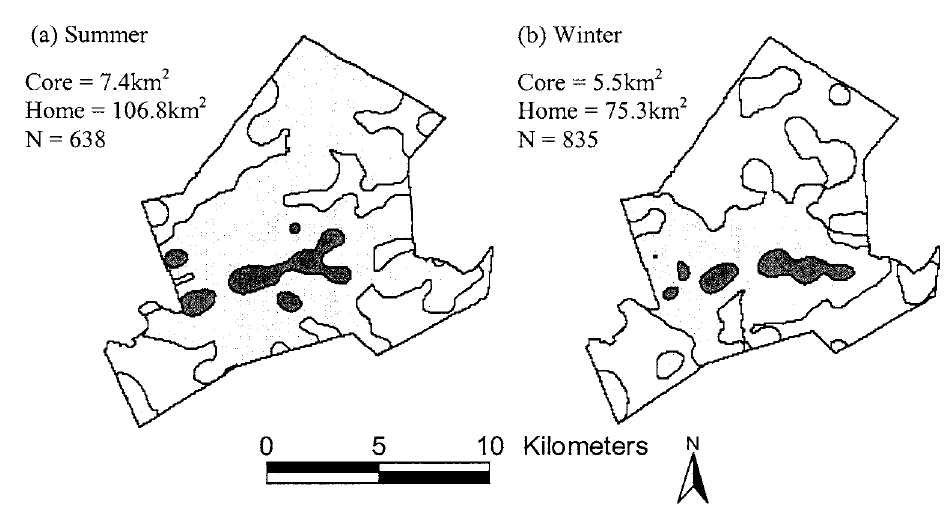
Fig. 5. The effect of season on lion spatial use. Core ranges (50 % kernel ranges) are shown in dark grey, while home ranges (95 % kernel ranges) are shown in light grey. (a) All lion ranges during the summer months; (b) All lion ranges during the winter